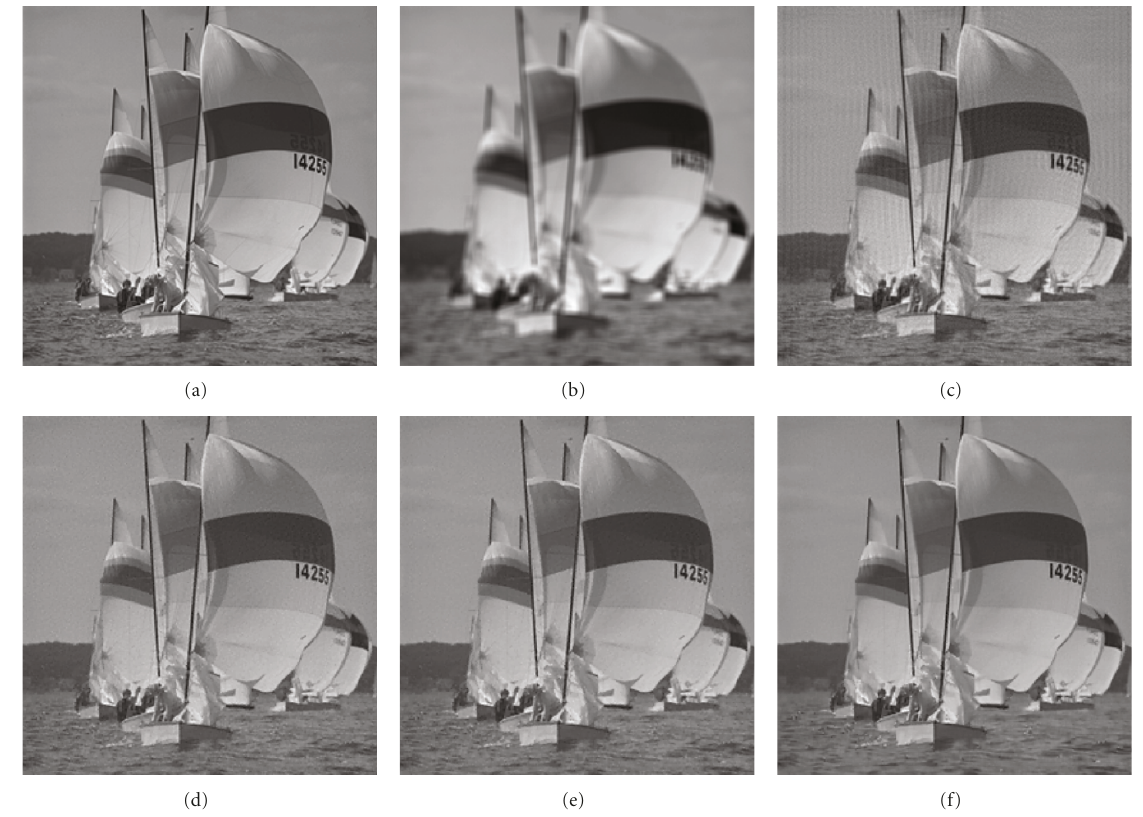
Figure 3: (a) Original “Sailing Boat” image. (b) Degraded “Sailing Boat” image (SNR = 6 . 97) with 7 × 7 uniform blur and additive white Gaussian noise (local variance = 0.3511). (c) Wiener filter restoration. (d) TV prior Bayesian restoration. (e) Nonquadratic Huber prior Bayesian restoration. (f) The proposed SA prior Bayesian restoration.